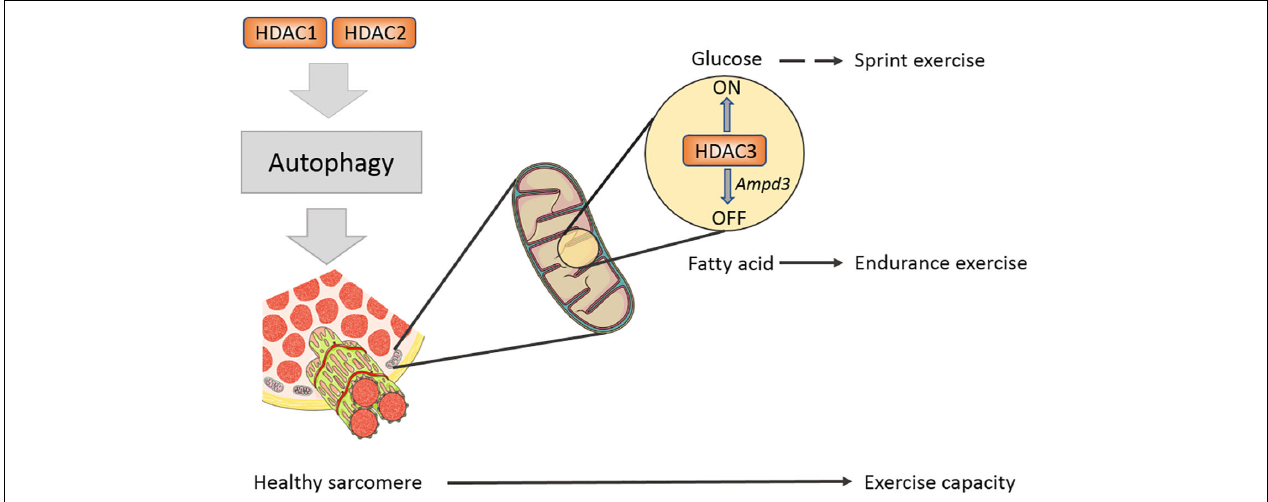
FIGURE 2 | Class I HDACs regulates sarcomere structure and exercise capacity in mature muscle. A schematic diagram shows Class I HDACs regulate exercise capacity on different levels. HDAC1/2 have redundant roles in modulating autophagy flux in muscle, eliminating toxic factors in muscle. HDAC3 serves as a fuel switch and promotes muscle to use fatty acid to adapt endurance